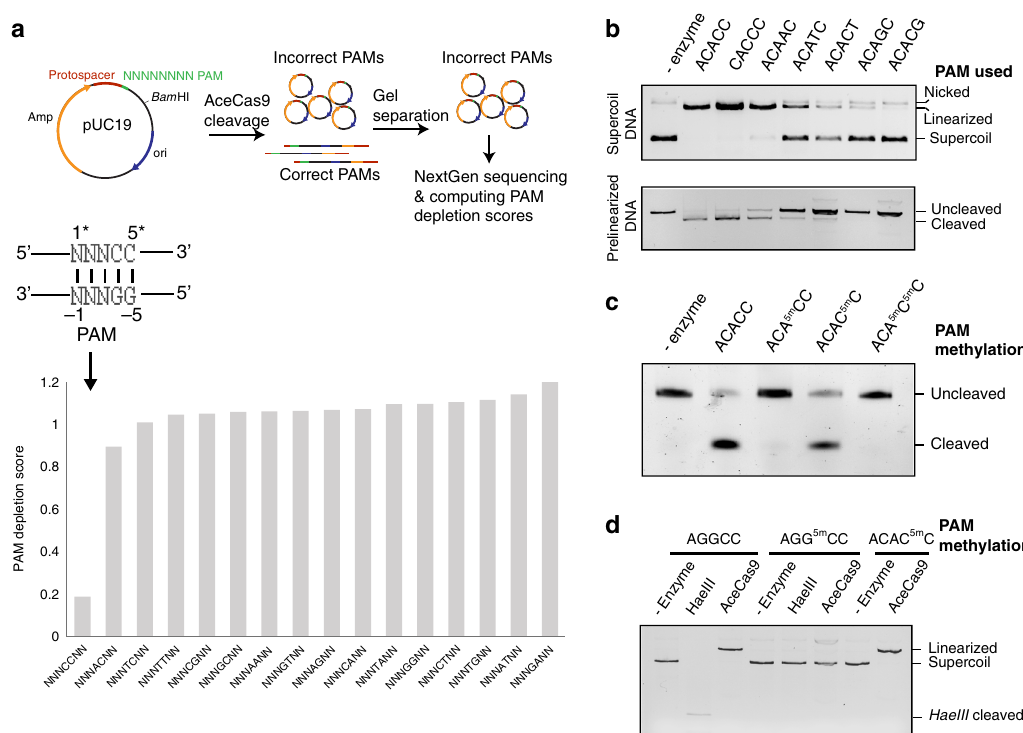
Fig. 1 Determination of the protospacer adjacent motif (PAM) for AceCas9. a The plasmid depletion assay scheme and the result. Seven base pairs immediately downstream of the protospacer are randomized. The plasmid depletion score is plotted for all possible dinucleotides at positions 4* and 5* and those of all other combinations are listed in Supplementary Data File 1. The PAM depletion score was computed as the ratio of the read frequencies in the AceCas9-treated and the untreated samples obtained from the Illumina sequencing (see details in “ Methods ” ). A low score identi fi es the PAM. b DNA cleavage activities of AceCas9 on plasmid substrates with various PAM sequences that differ in positions 1* – 5*. Each DNA substrate at 6 nM concentration was incubated with 1 μ M AceCas9 at 50 °C for 1 h followed by gel separation and ethidium bromide staining. Top: Cleavage results of supercoil plasmids. Bottom: Cleavage results of pre-linearized plasmids. c DNA cleavage activities of AceCas9 on DNA oligomers containing either non-methylated or methylated PAM. The target DNA strand is not methylated and contains a 5 ′ -hexachloro fl uorescein (HEX) tag for visualization. The nontarget strand contains methylation on C4*, C5*, or both, respectively, and was heat-annealed with the target strand at 1 nM concentration before incubating with 1 μ M AceCas9 RNP for 50 min at 50 °C. d DNA cleavage activities of AceCas9 on DNA plasmids containing non-methylated and or methylated PAM. Methylation of C4* was achieved by treatment of the DNA plasmid containing the PAM followed by GGCC sequence with HaeIII methyltransferase. The HaeIII restriction endonuclease ( HaeIII ) was used to verify the methylation. Methylation of C5* was achieved in a dcm1 -positive E. coli by ampli fi cation of the plasmid containing the CCWGG (W = A or T) sequence. Source data are provided as a Source data fi